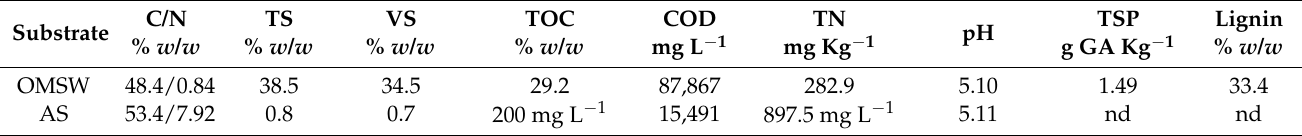
Table 3. Olive mill solid waste and Aquaculture sludge